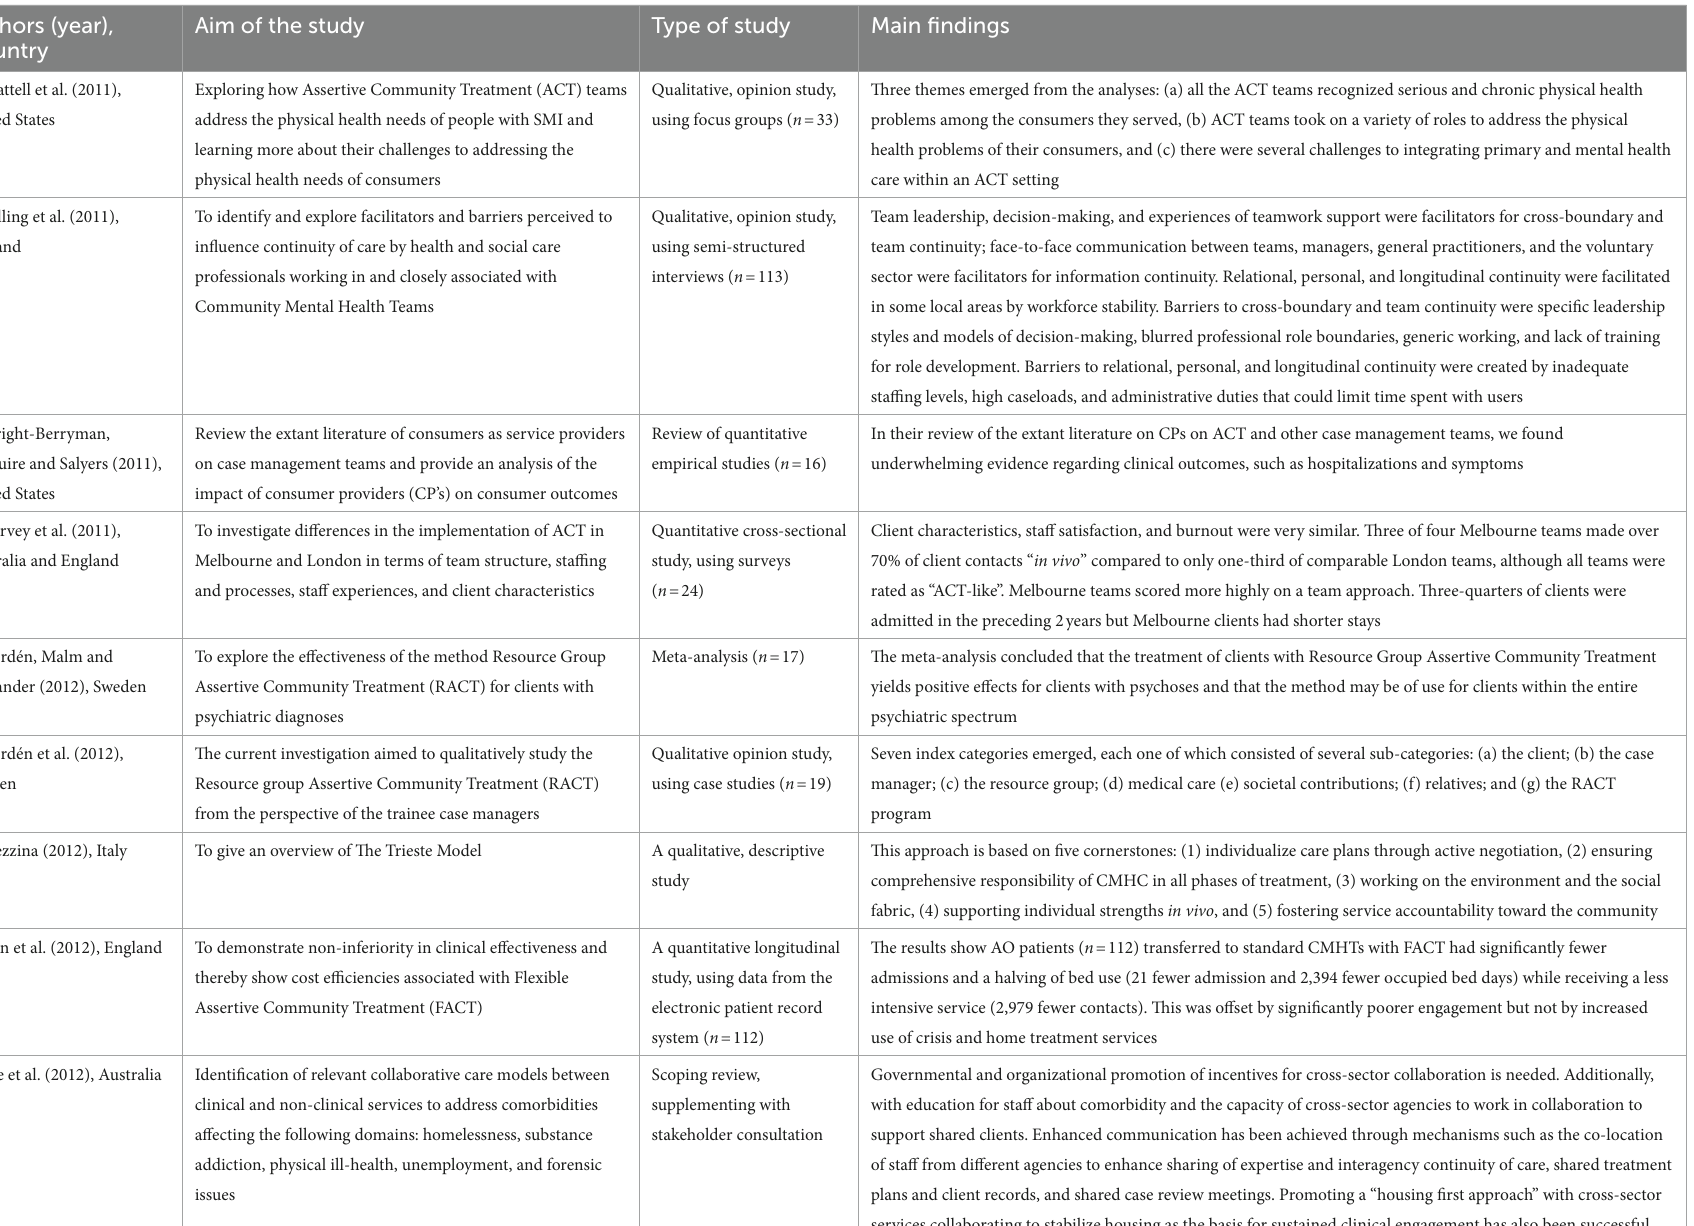
TABLE 1 Summary of papers included in the scoping